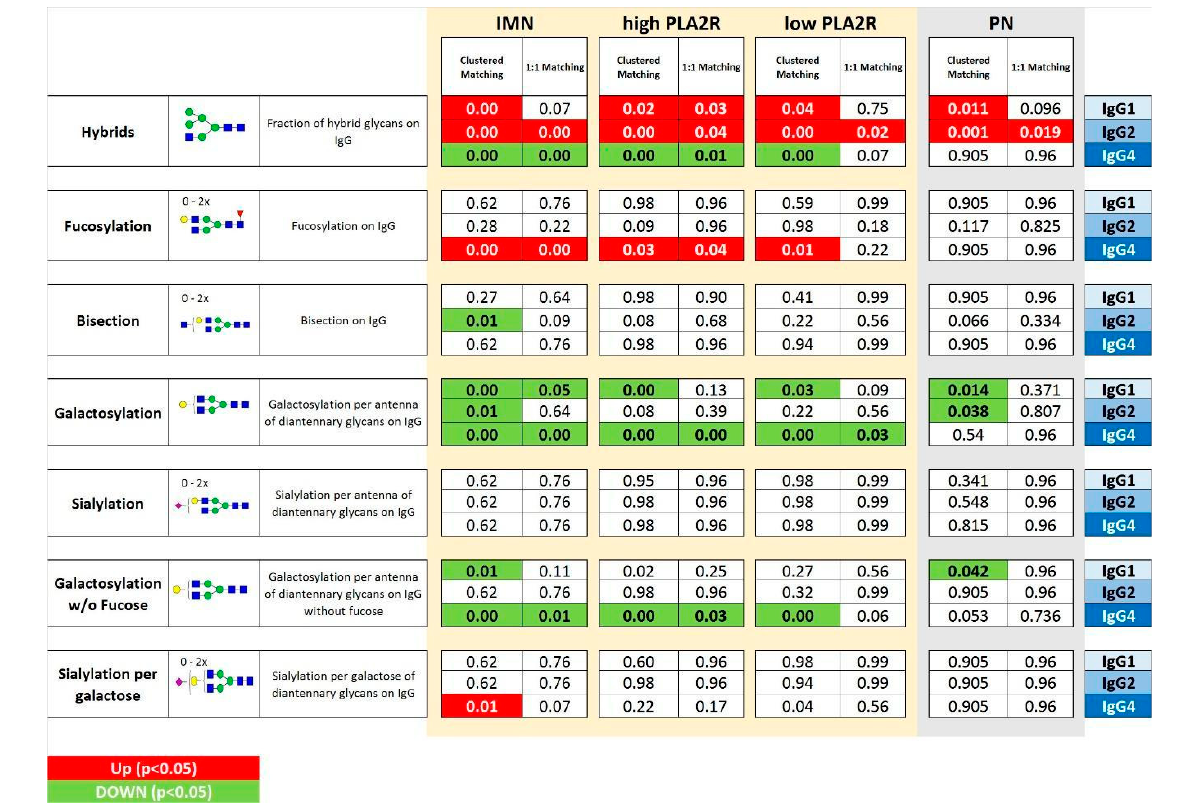
Figure 5. Overview of IgG Fc glycosylation signatures of idiopathic membranous nephropathy ( IMN ) and other nephropathies that are different from IMN ( PN ), compared in both cases to healthy controls. The p -values are given for seven N-glycosylation traits of serum IgG1, 2, and 4. Significant differences ( p < 0.05) are highlighted in bold and colored based on the direction of the difference ( green for lower values and red for higher values in disease vs. control). The IMN patients were used all together ( IMN ) or based on PLA2R titer ( HighPLA2R if > 999; Low PLA2R if < 999). For the comparisons, sex- and age-matching with healthy controls were performed based on the clustered and one-to-one approach.